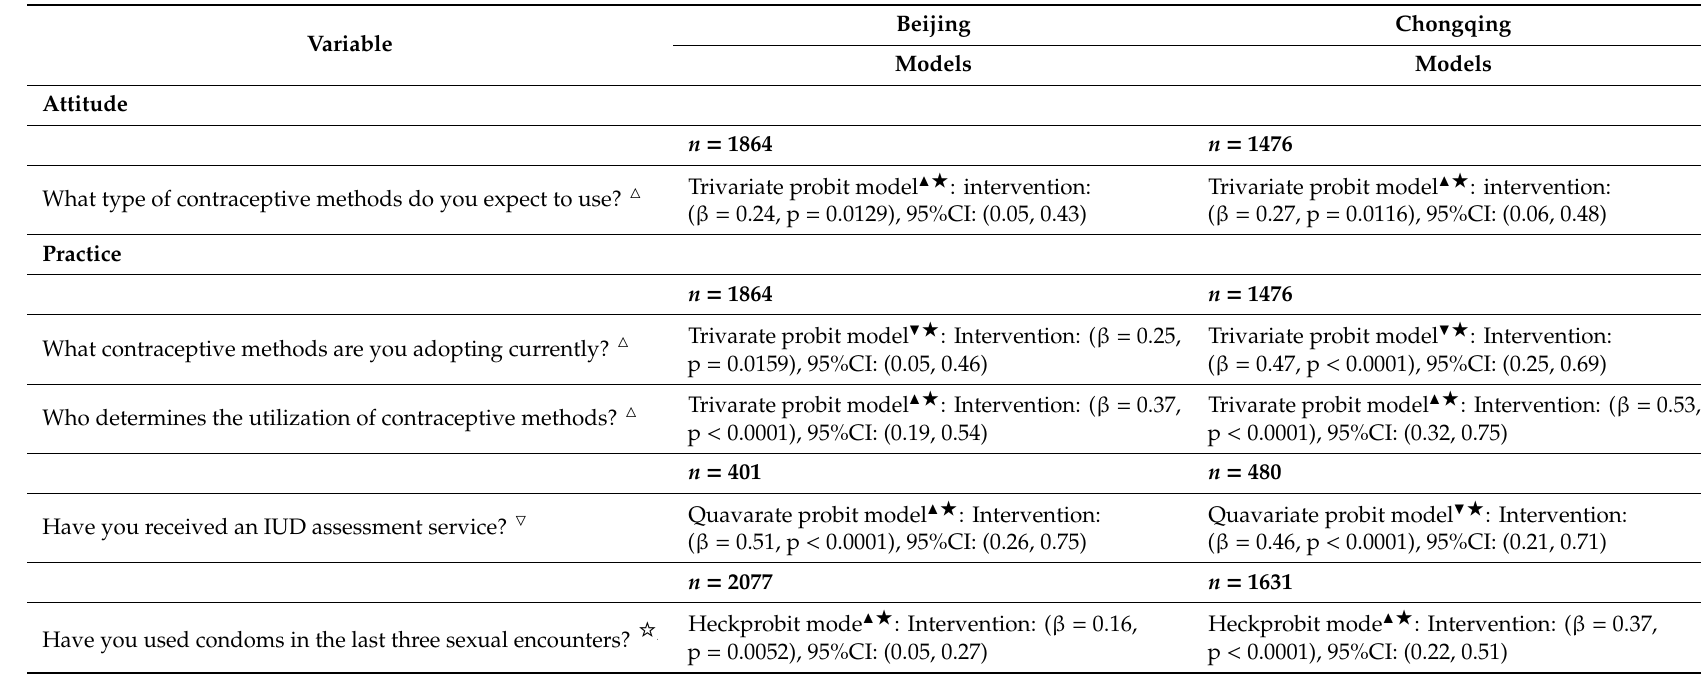
Table 4. Effects of the intervention on attitudes and practices among participants by multivariate models. Variable